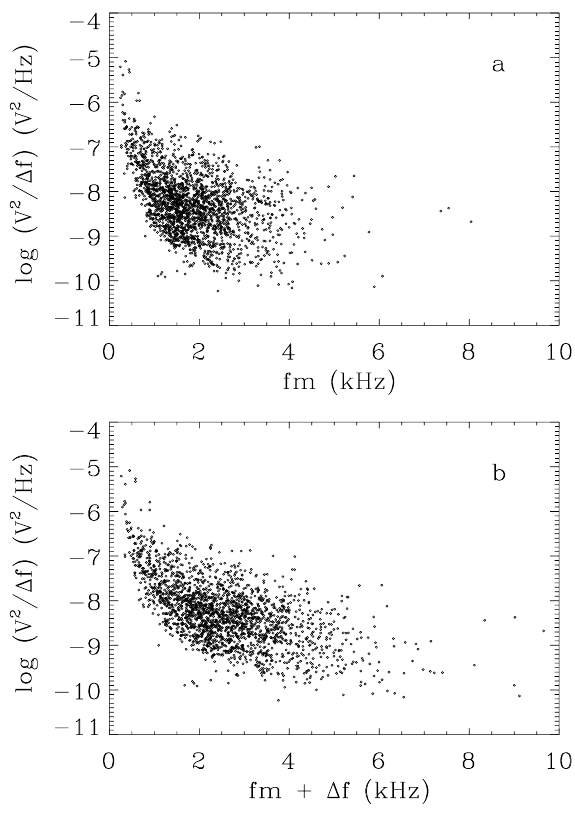
Fig. 2. Spectral power of the electric potential in the coherent elec- trostatic waves. (a) as a function of their central frequency f m . (b) as a function of their maximum frequency f m + 1f